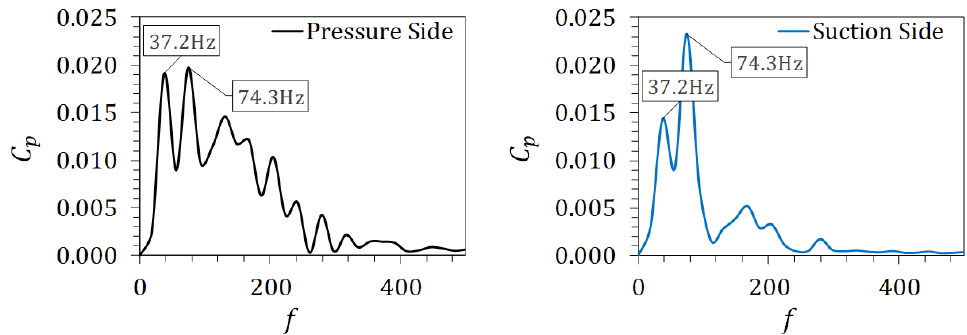
Figure 20. Frequency spectra of the pressure fluctuation on monitoring points on the blade surface.